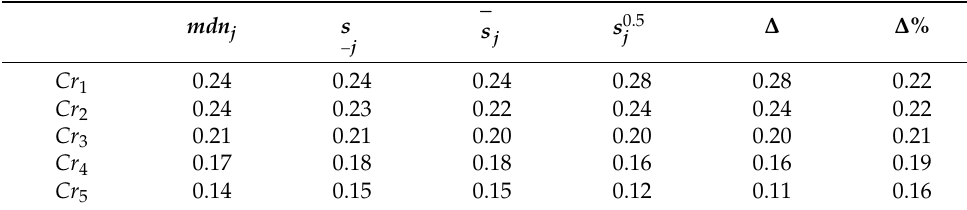
Table 4. Median, left, and right bounds of grey